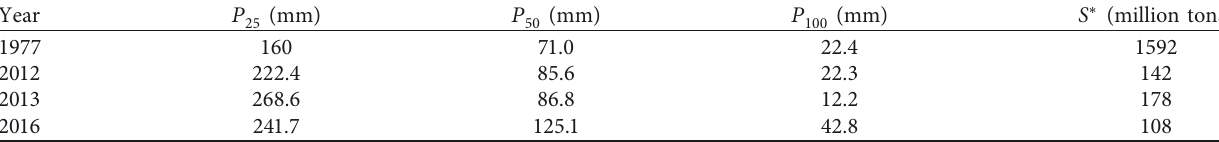
Table 7: Comparison of precipitation over the heavy rainfall events and the sediment yield of the HLR in typical years. Year